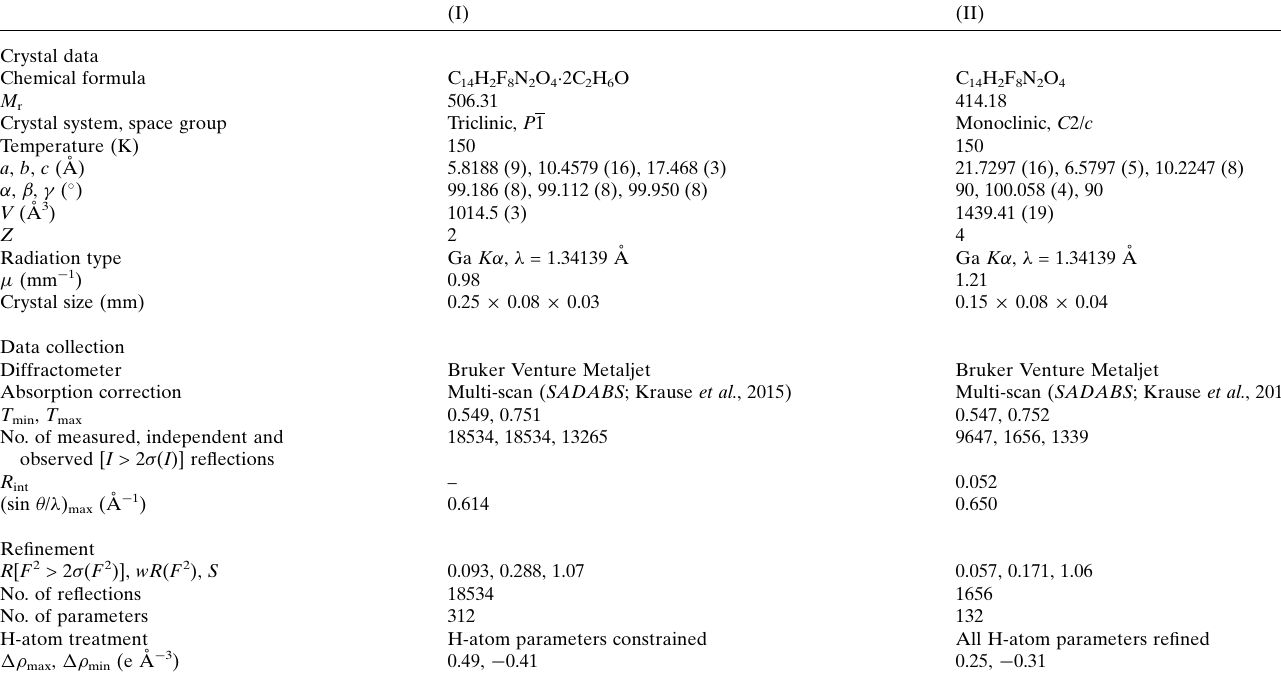
Table 3 Experimental details.